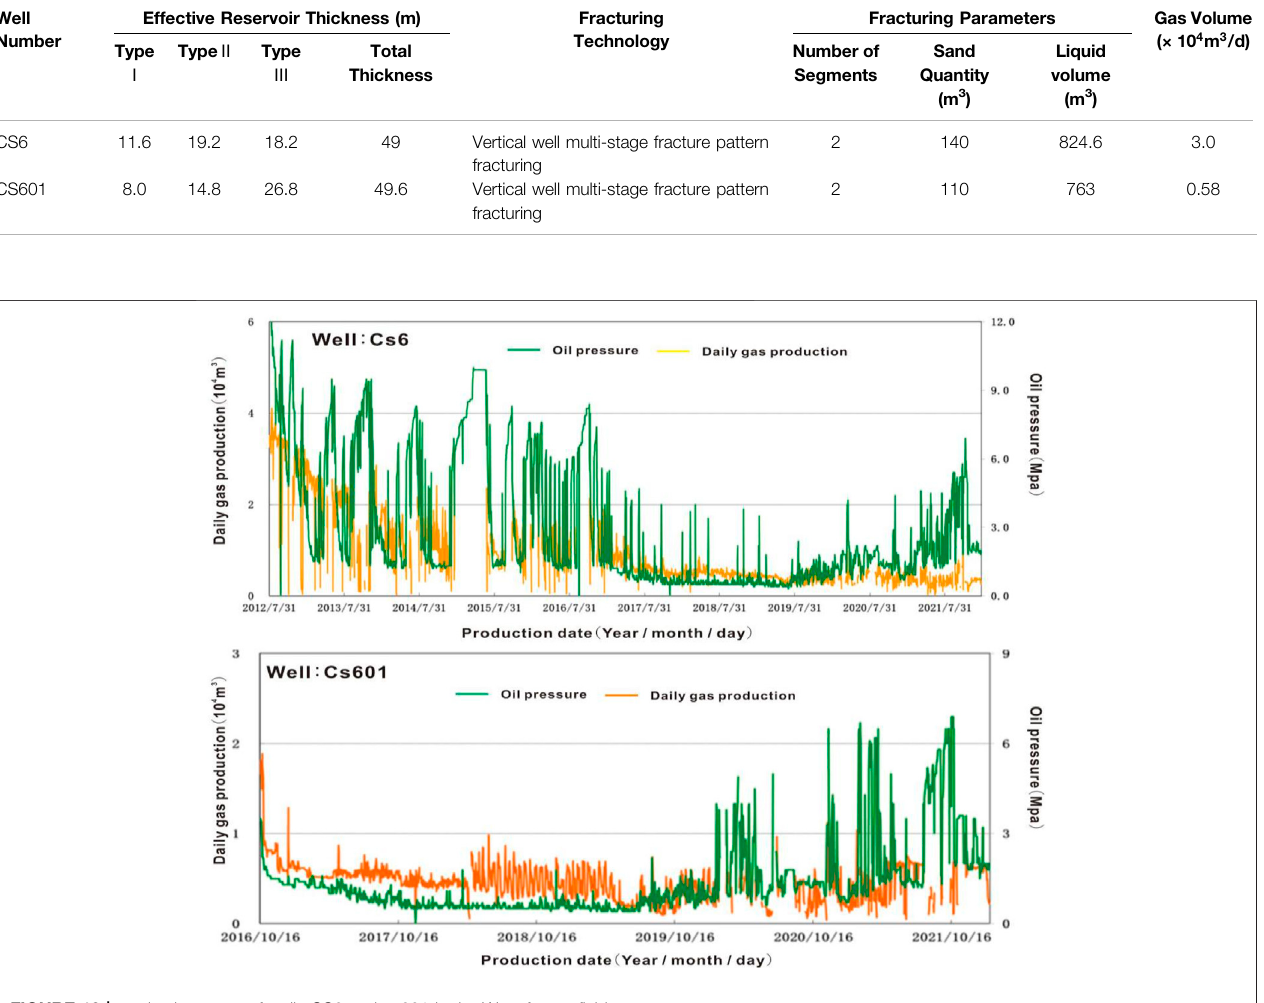
FIGURE 13 | production curve of wells CS6 and cs601 in the Wangfu gas fi eld.